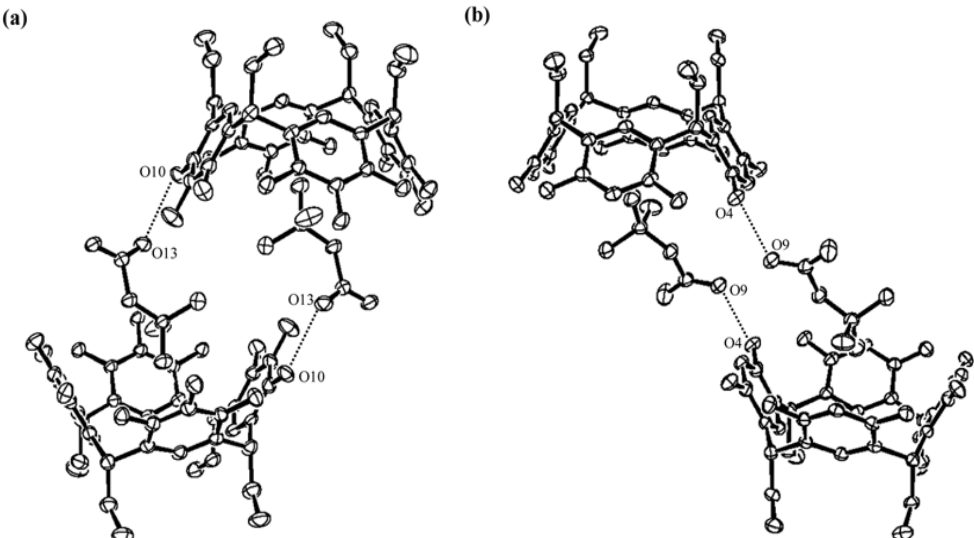
Figure 2. The slid complex pair structures composed of two complexes. One complex is composed ( a ) of a betaine molecule and a PCT molecule; and ( b ) of a betaine molecule and a RCT molecule. Ethanol and water molecules are not drawn for clarity. Hydrogen bonds between two complexes are represented by dotted lines. Each upside-down structure is positioned with crystallographic symmetry. It is inferred that one more hydroxyl group per aromatic ring of PCT compared to RCT prevents the PCT complex from forming the same structure as the RCT